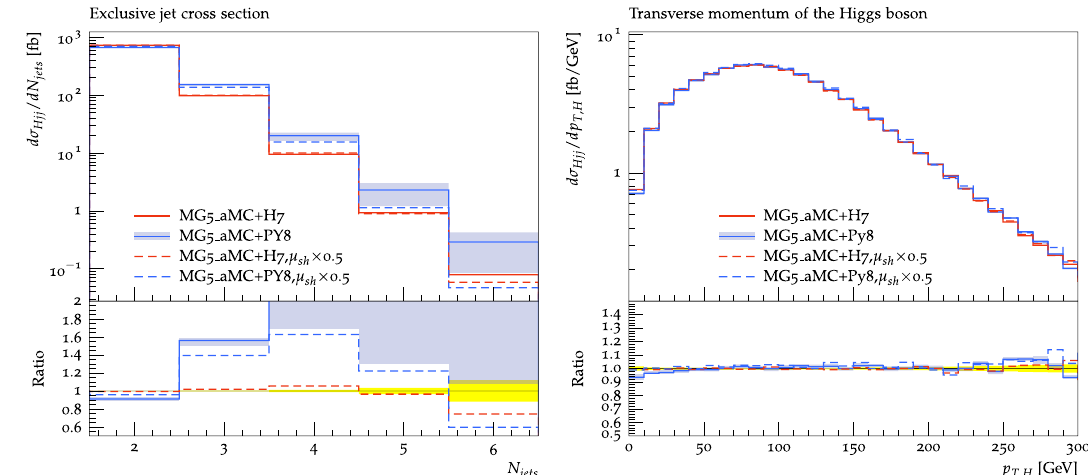
Fig. 2 Predictions at NLO + PS accuracy for the exclusive jet multi- plicities (left) and for the transverse momentum of the Higgs boson (right) obtained with MadGraph5_aMC@NLO . Red and blue his- tograms correspond respectively to matching with HERWIG7 and PYTHIA8 . Solid lines correspond to the default shower scale, while